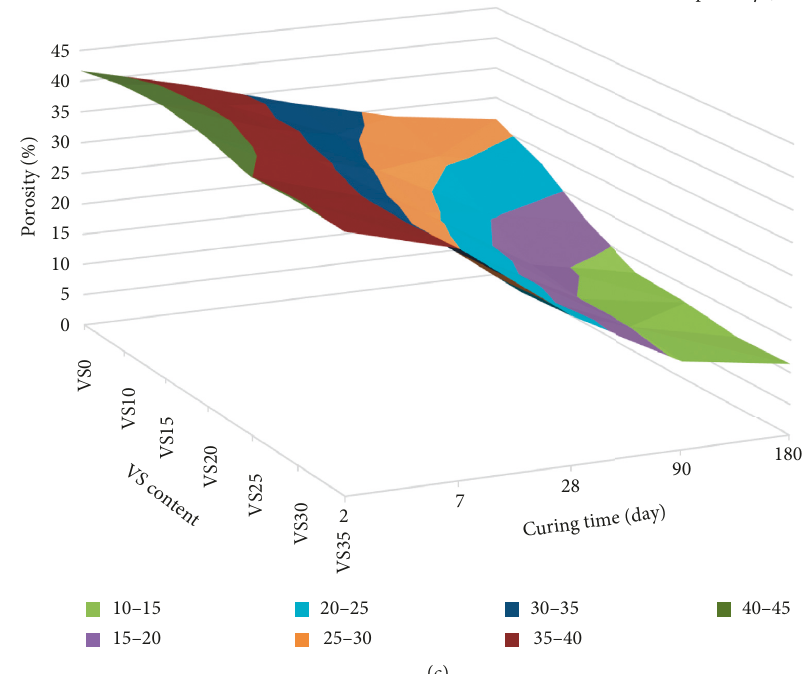
Figure 11: Porosity values of VS-based binder concretes of various w/b ratios cured for different times: (a) w/b � 0.5; (b) w/b � 0.6; (c) w/b � 0.7.